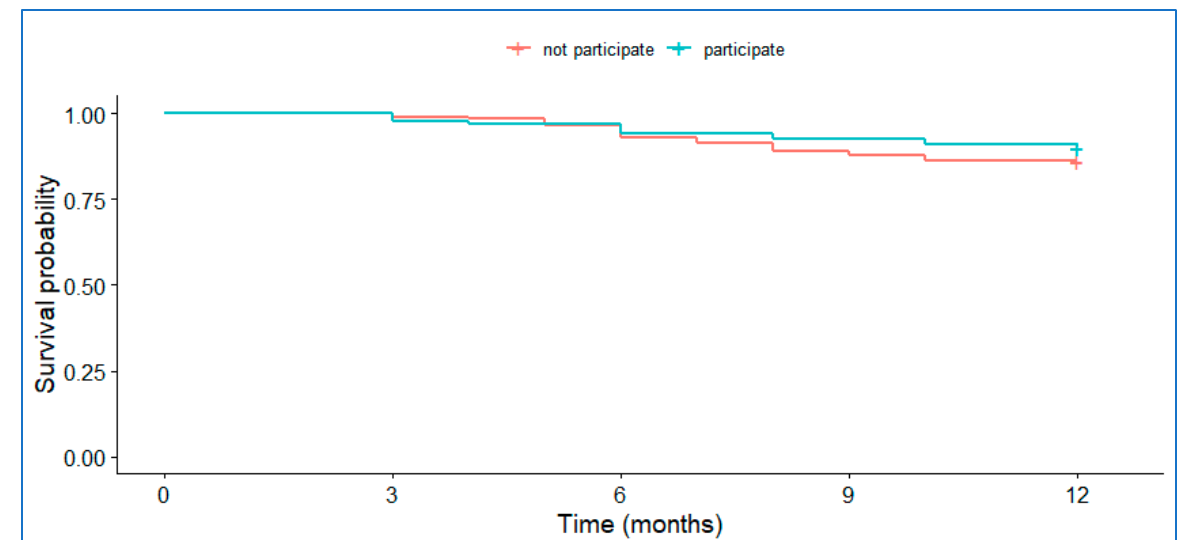
Figure 4. Debt moratorium/waiver of debt repayment/debt correction NPL program participation (P2).